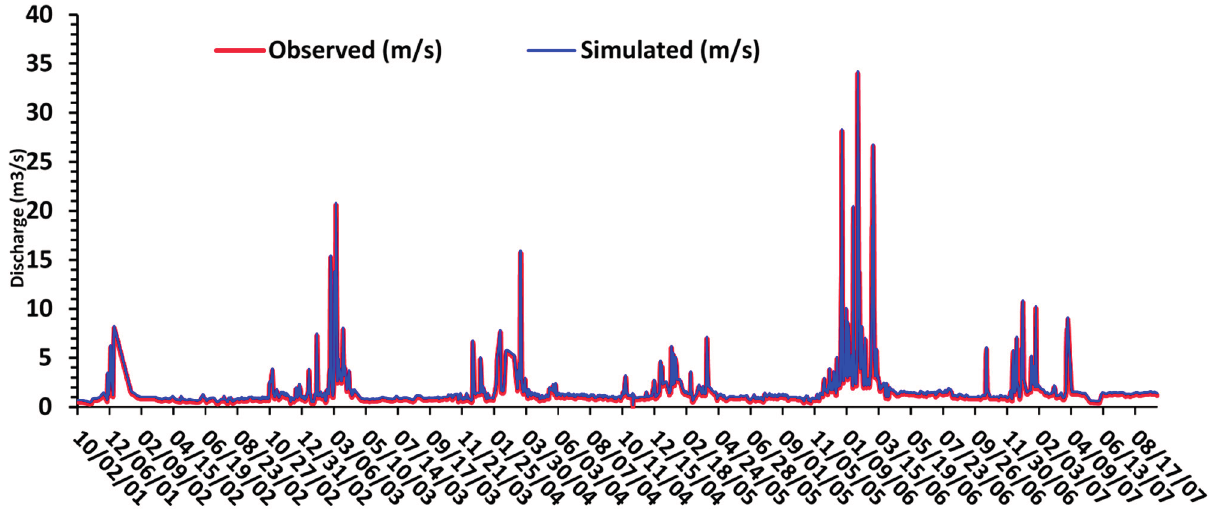
Figure 4. Model calibration results Marimba catchment (October 2001–September